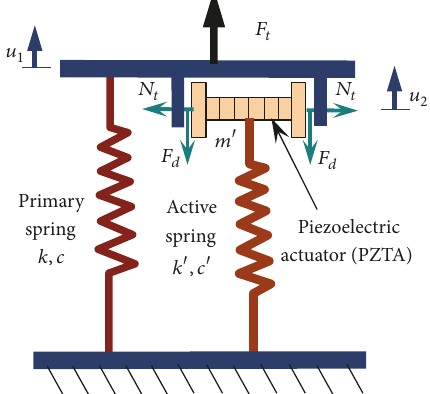
Figure 1: The Smart Spring system